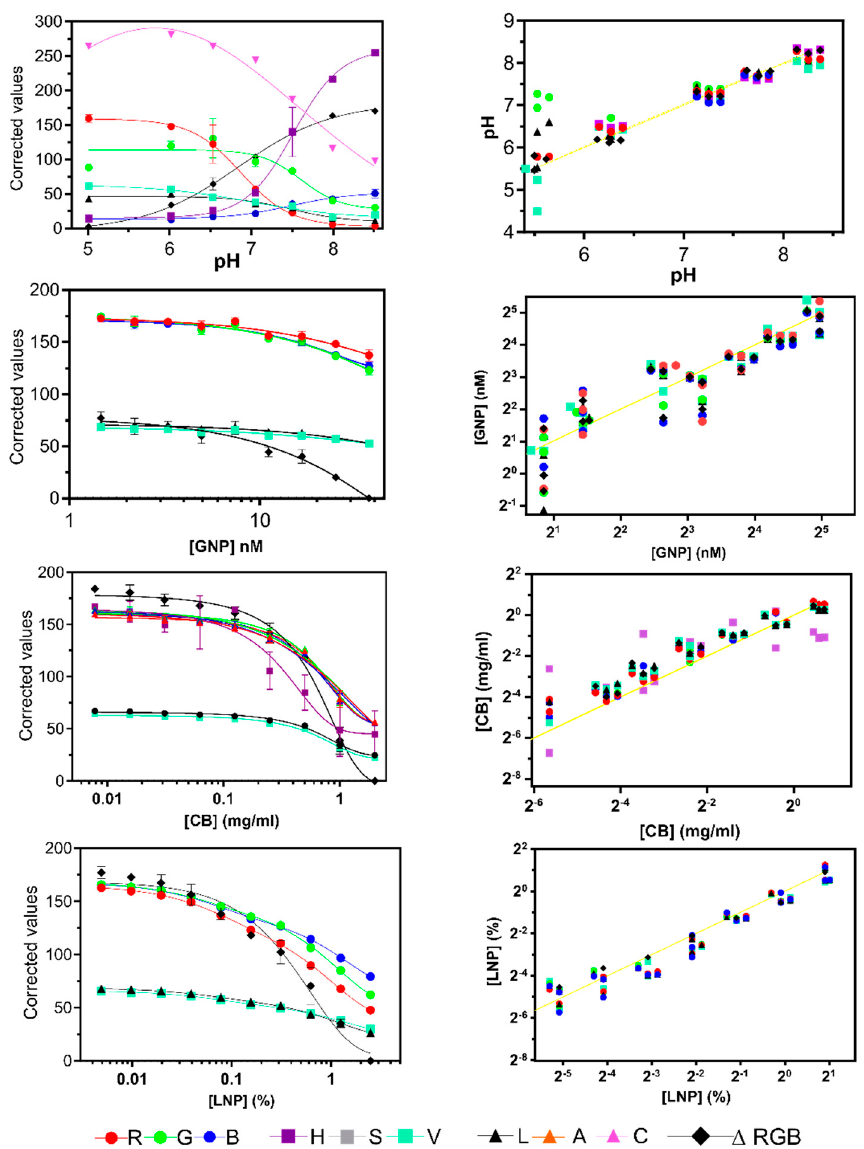
Figure 6. The left column shows calibration curves (with an R 2 > 0.8) obtained from background corrected channel values from the RGB, HSV, and LAB (Called LAC to avoid confusion of the B channels of RGB and LAB) color spaces for various pH values, GNP, CB, and LNP concentrations. The right column shows scatter plots of predictions obtained with those calibration curves. The yellow line represents a perfect correlation (slope = 1). Color and symbol codes are indicated.